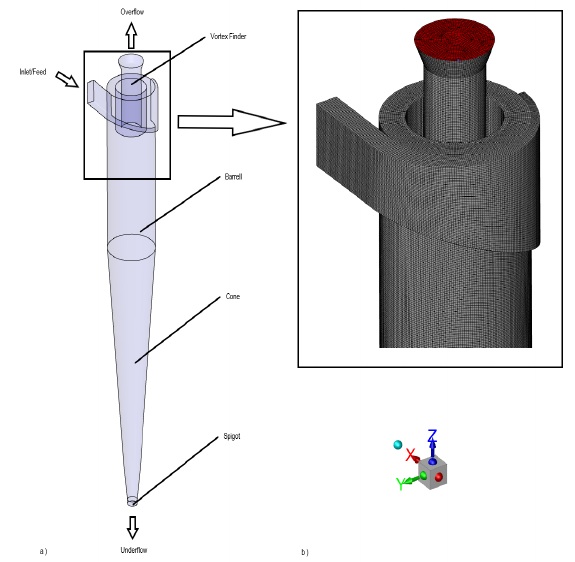
Figure 3. Hydrocyclone ( a ) geometry and ( b ) computational